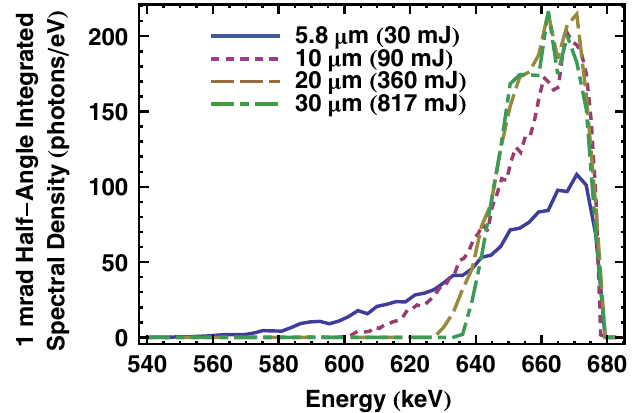
FIG. 7. (Color) Plot of the predicted integrated spectrum of the (cid:1) -ray source as a function of electron rms spot size. Smaller sizes show broadening due to the large angular distribution of the electron